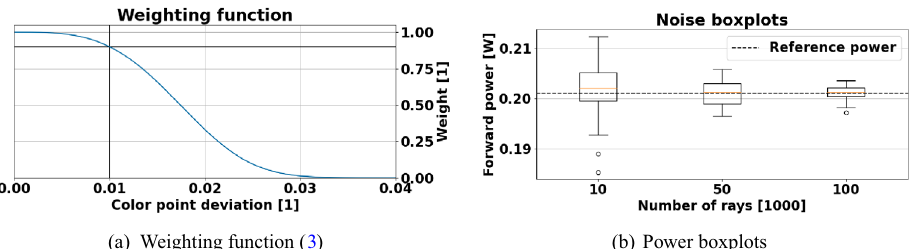
Figure 3. ( a ) The weighting function (3) for a = − 634914.5425 and b = 3.3900 . The dark lines emphasize the traced rays ( 10 × 10 3 , 50 × 10 3 and 100 × 10 3 ) is started 15 times. The conversion material weight